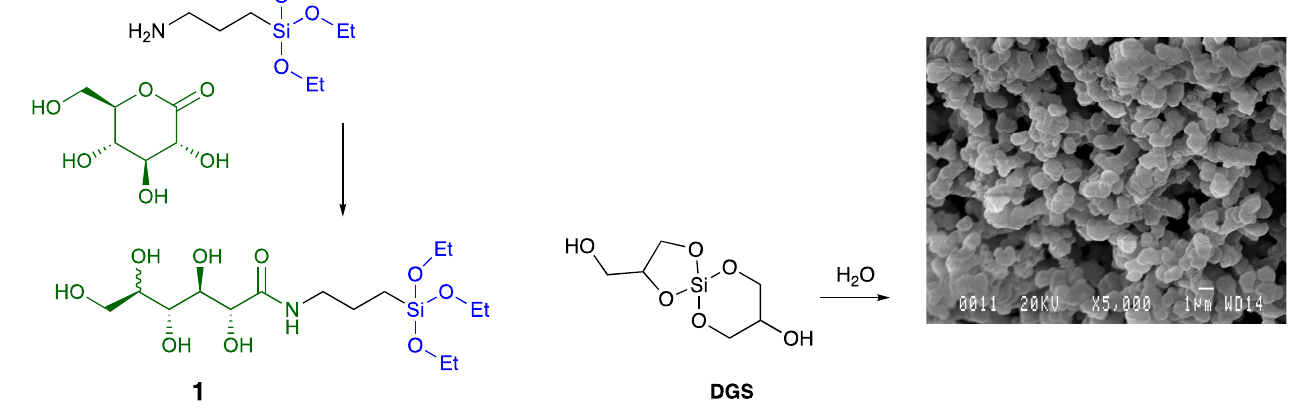
Figure 1. DGS , 1 , and the resulting monolithic silica formed (at left ) by hydrolysis